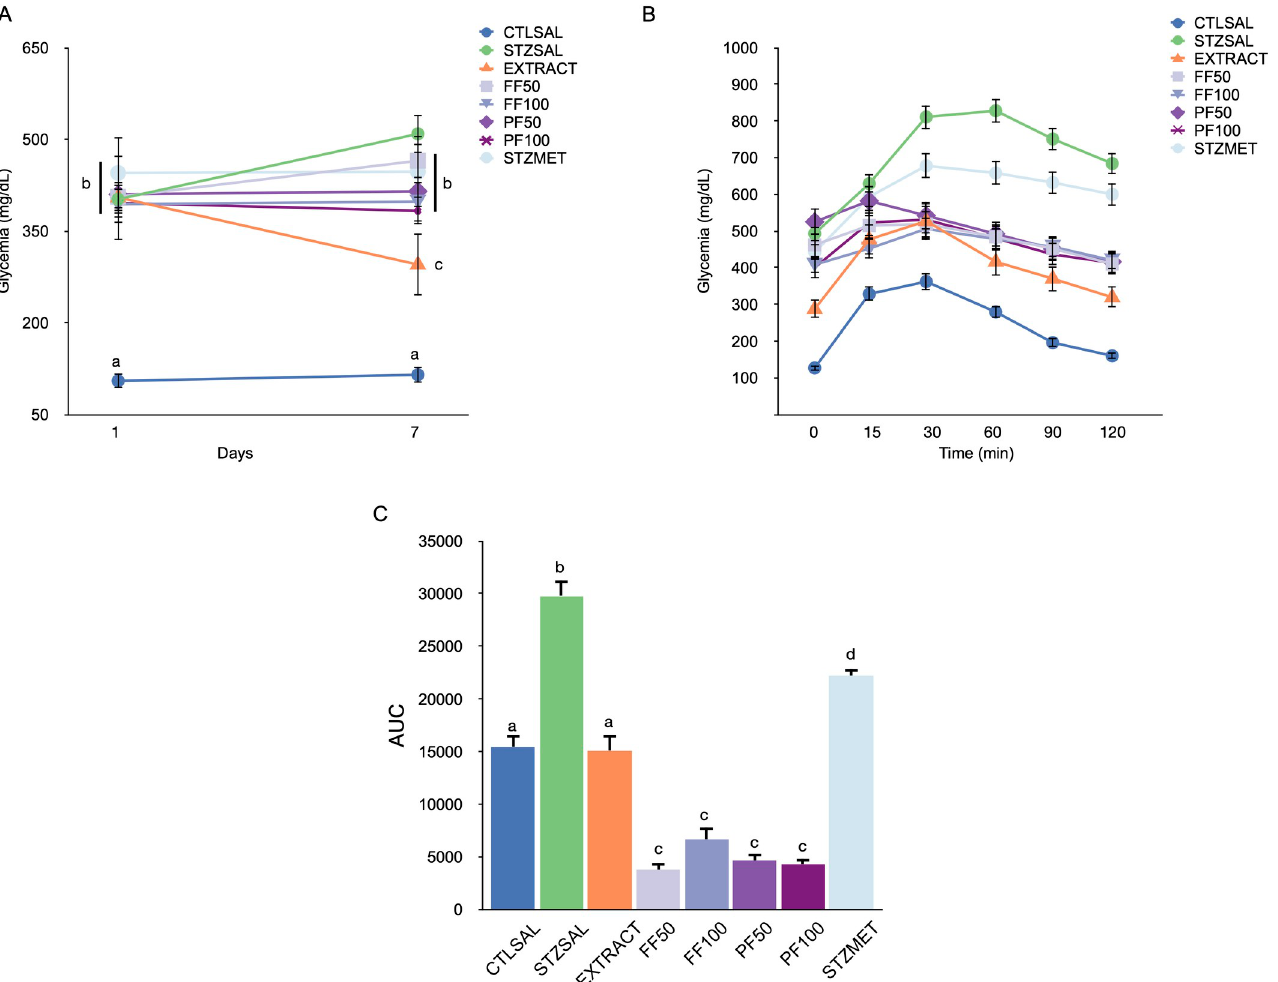
Fig 2. ( A ) Effect on blood glucose tolerance of treatment with the hydroalcoholic extract of Bauhinia holophylla leaves (400 mg/kg b.w.) and the flavonoid fraction (FF50) 50 mg/kg b.w., (FF100) 100 mg/kg b.w., polar fraction (PF50) 50 mg/kg b.w. and (PF100) 100 mg/kg b.w. and ( B ) area under the curve. The results are expressed as means ± SEM (n = 8/group). Different letters indicate significant differences between groups. ANOVA followed by Tukey- post-test , p < 0.05.